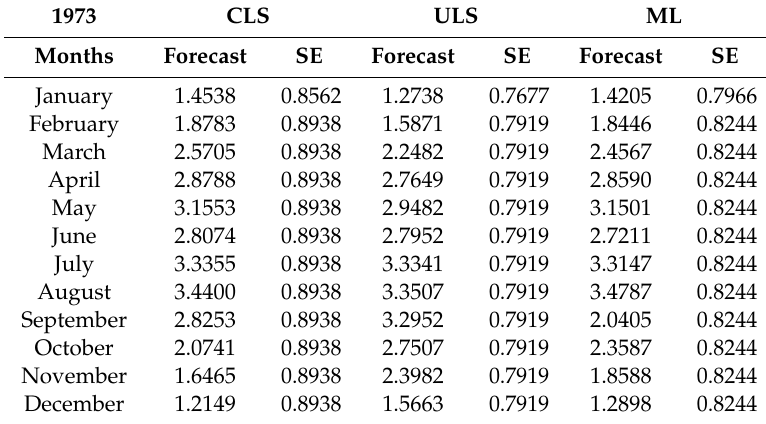
Figure 3. The forecast for year 1973 by three different algorithms: ML, ULS, and CLS. Table 3. Forecasting the year 1973 using three ARIMA estimation algorithms: CLS, ULS, and ML.